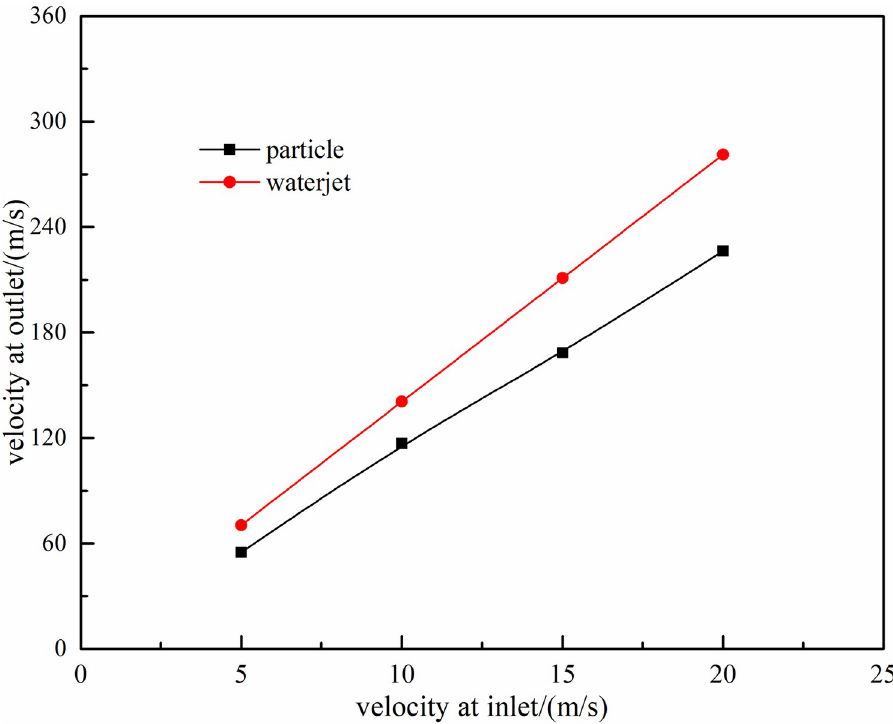
Fig 5. The effect of velocity change at nozzle inlet on acceleration of